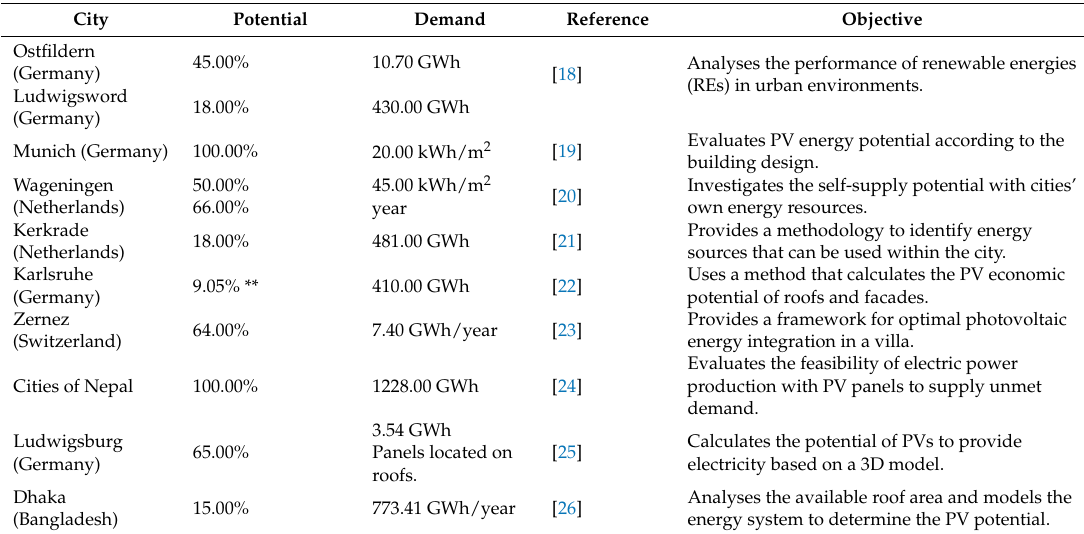
Table 1. The estimation of solar potential in